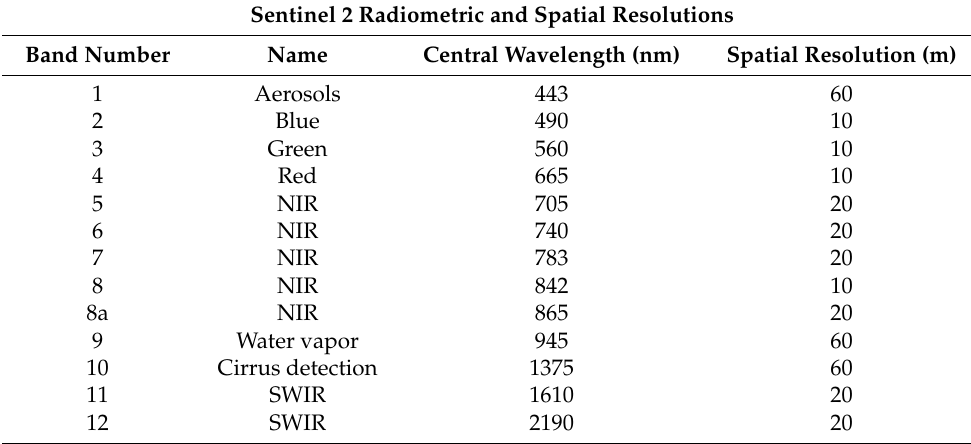
Table 1. Radiometric and Spatial resolution of